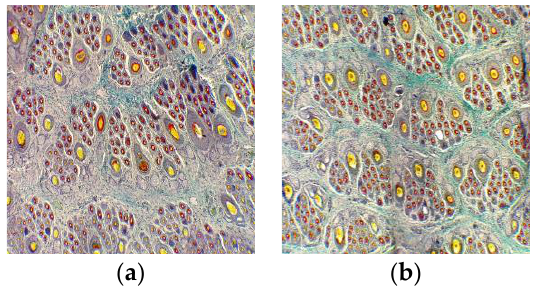
Figure 3. Representative hair follicle groups based on horizontal sections stained via the Sacpic method in control and supplemented groups (40×). ( a ) Representative hair follicle groups in the skin of kids in the control group at the age of 15 days; ( b ) representative hair follicle groups in the skin of kids in the supplemented group at the age of 15 days.